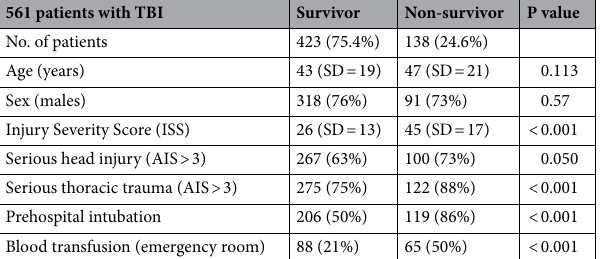
Blood transfusion (emergency Table 6. Characterization of survivors vs. non-survivors among patients with tracheobronchial injuries.